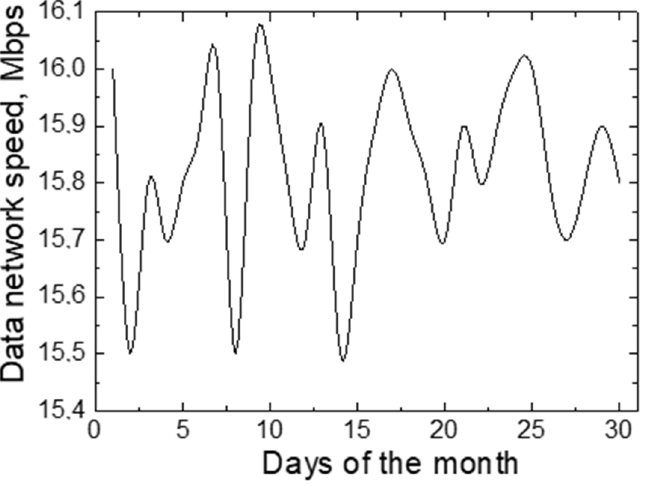
Figure 2. Hybrid data network speed.